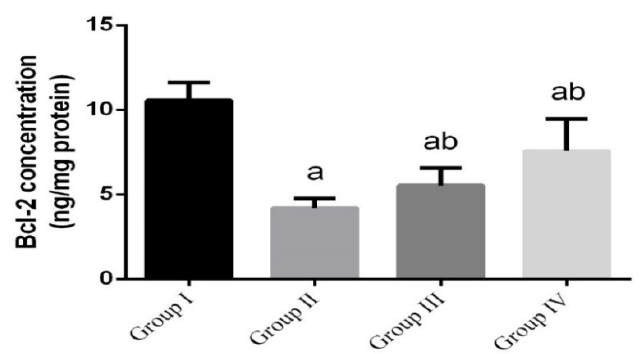
Figure 5. The e ff ect of green Ag-NPs using G. mangostana on intestinal antiapoptotic protein (Bcl-2).